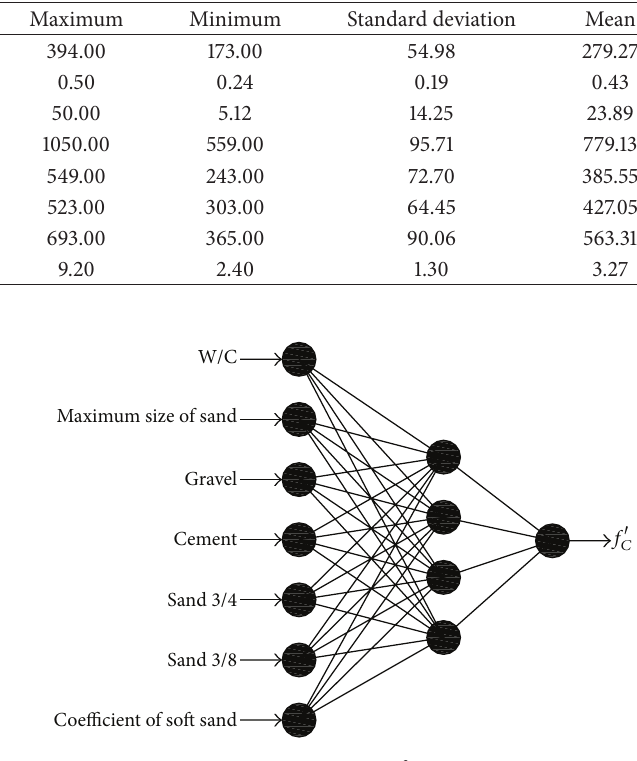
Figure 1: Structure of